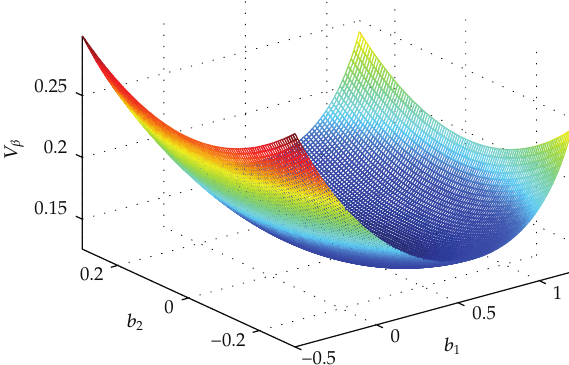
Figure 5: V β as a function of b 1 and b 2